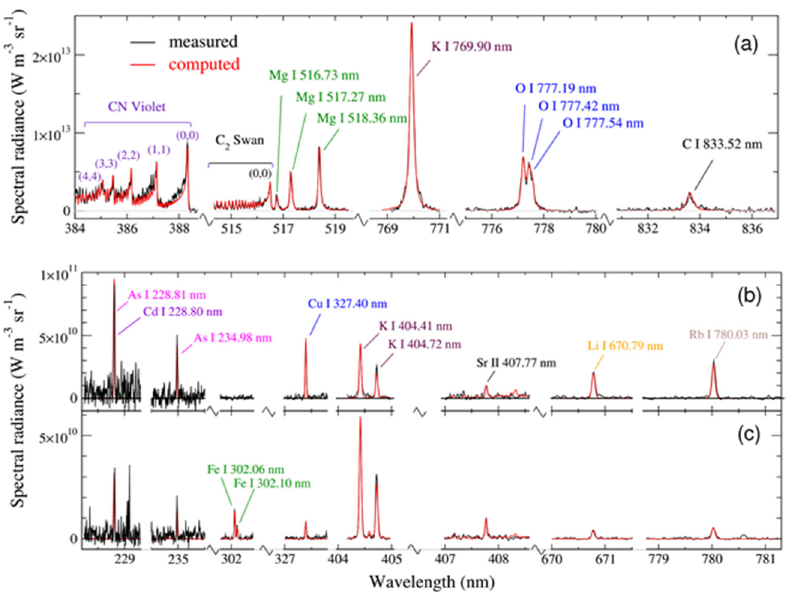
Figure 17. Elemental analysis of seafood. The spectrum recorded for sepia with t = 350 ns is ( a ) used to quantify the organic matrix and the most abundant minerals. The spectra recorded for sepia ( b ) and sardine ( c ) with t = 4.5 μ s provide the quantification of trace elements.